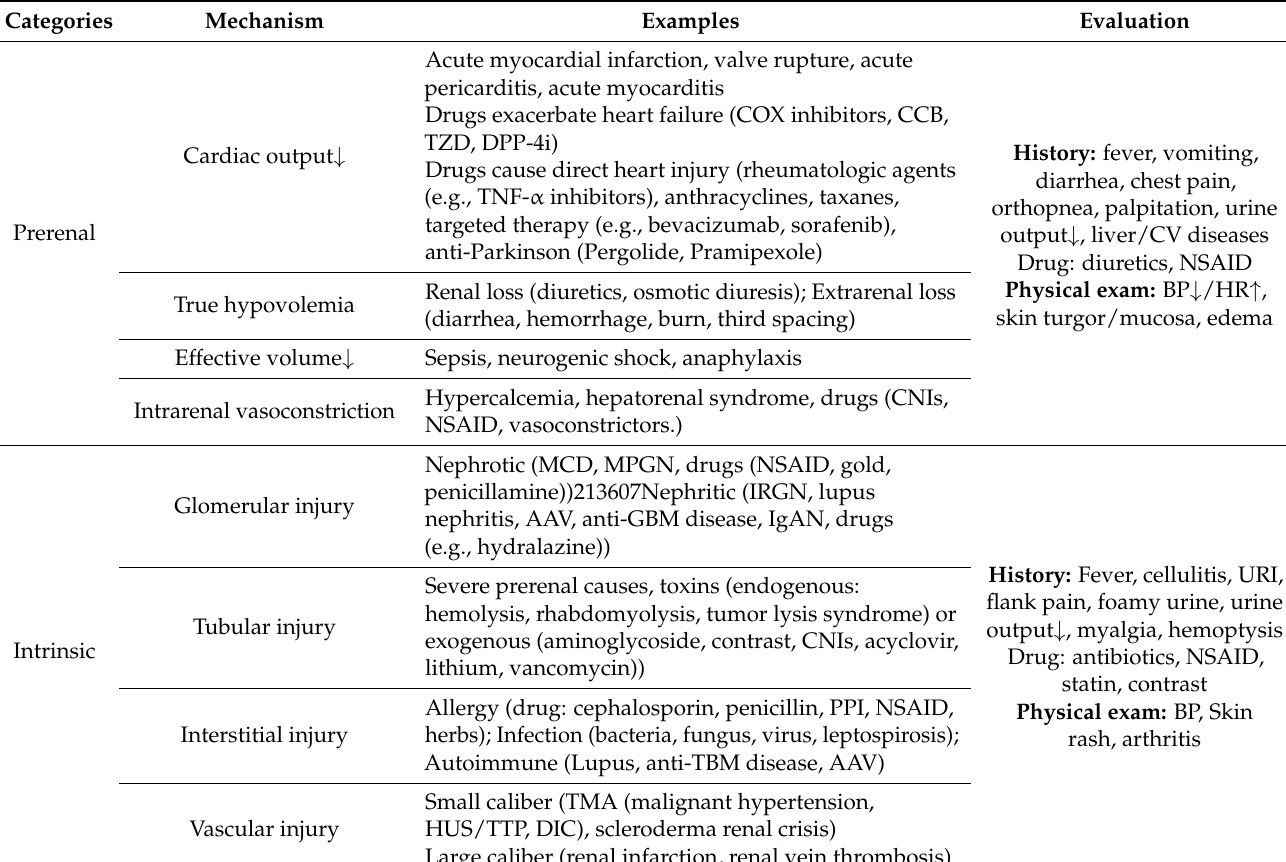
Table 1. Common etiologies of acute kidney